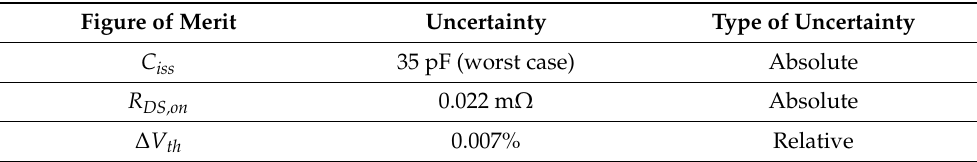
Table 1. Measurement absolute uncertainty of the device figures of merit. Figure of Merit Uncertainty Type of Uncertainty C